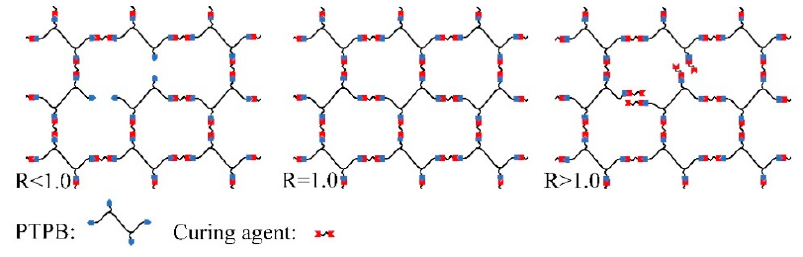
Figure 7. PT ri PB elastomer network structures.